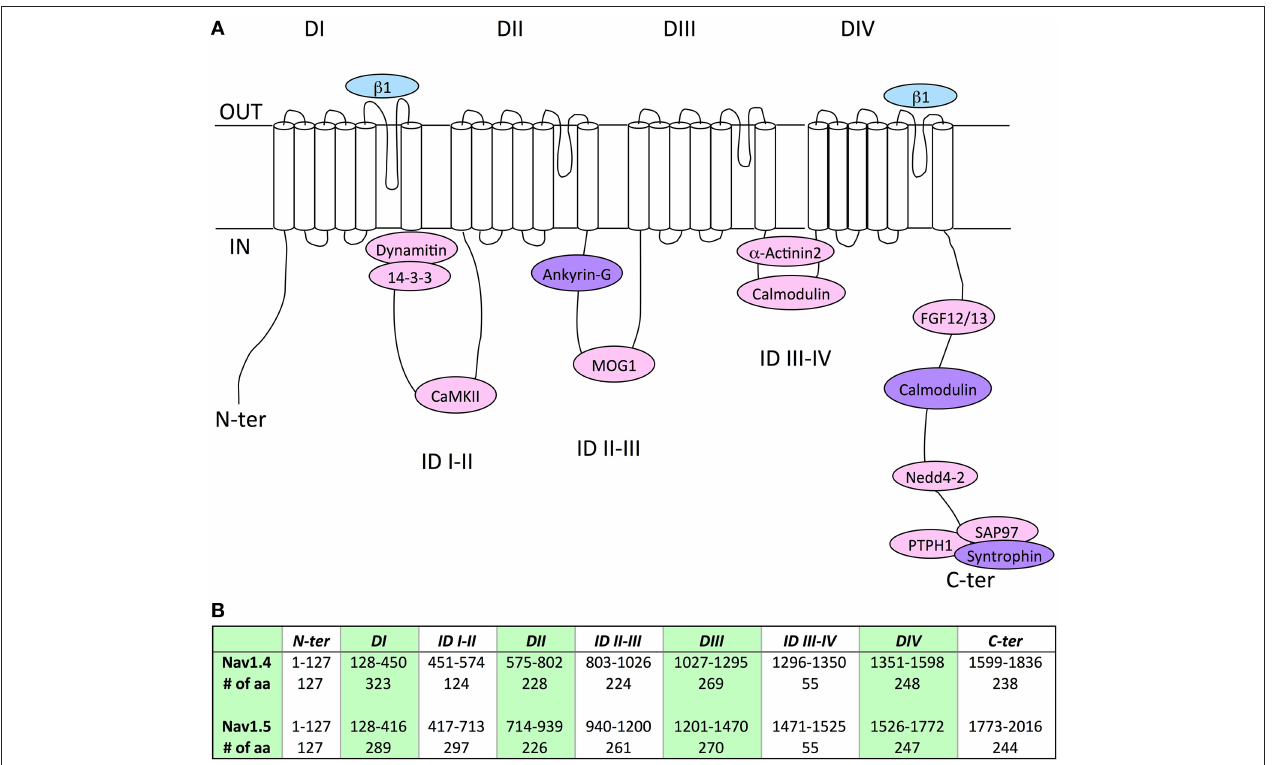
FIGURE 1 | (A) Schematic representation of the localization of the binding sites of associated/regulatory proteins identified for Nav1.4 (blue), Nav1.5 (pink), or both (purple). Nav1.4 interaction with ankyrin is only suggested by chimeric constructs, it remains to be studied with full length proteins (Lemaillet et al., 2003). DI to DIV, domains I to IV; ID, intracellular interdomains; N-ter and C-ter, N-and C-terminus ends. (B) Table presenting the amino-acid (aa) numbering and length of specific regions and domains in Nav1.4 and Nav1.5 proteins. It is noticeable that Nav1.4 IDI-II total amino-acid length is shorter than Nav1.5 IDI-II.